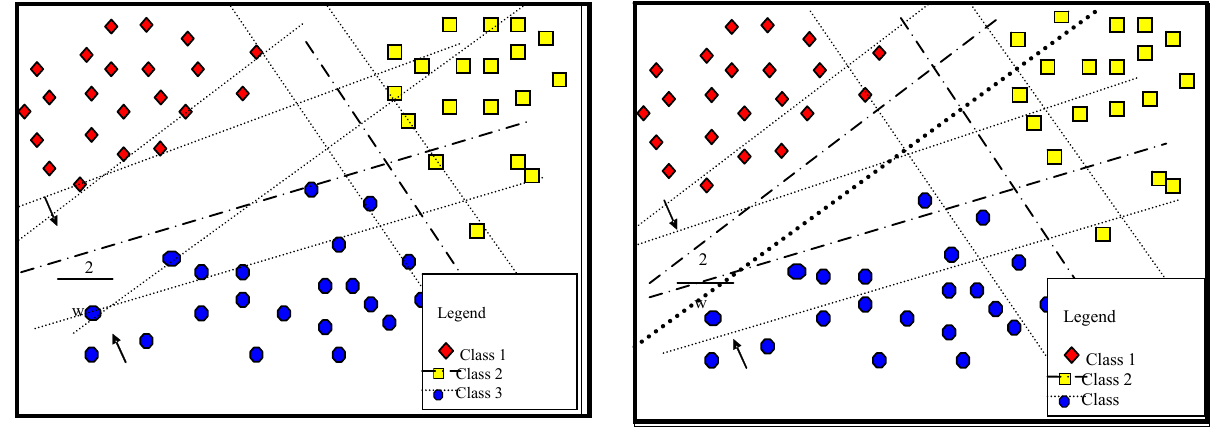
Figure 1.a Standard Multiclass SVM. Figure 1.b Proposed